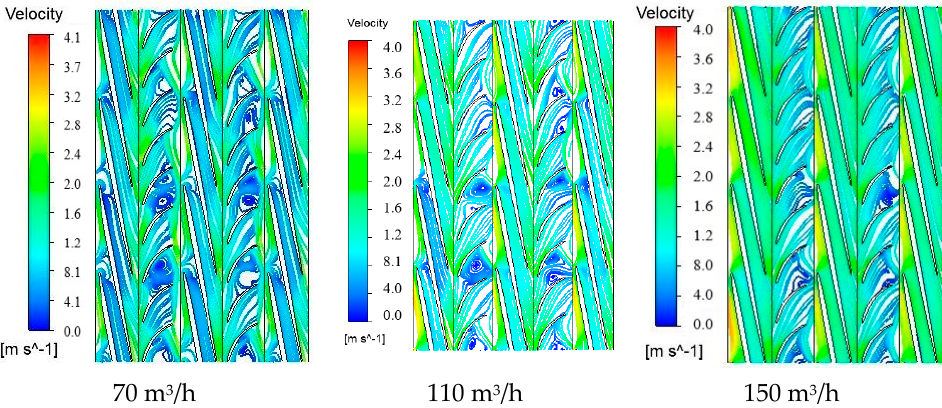
Figure 11. The streamline distribution at 0.8 blade height of multiphase pump pressurizing units.